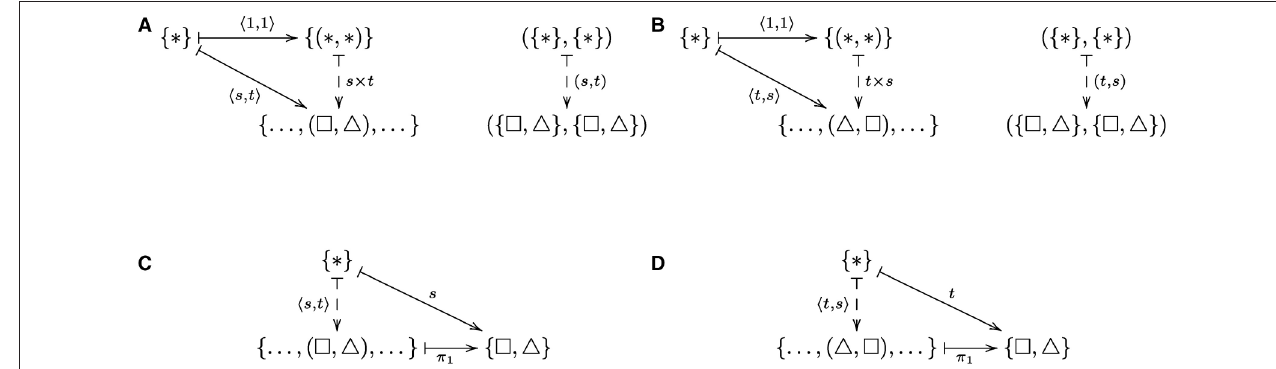
FIGURE 1 | Systematicity with regard to (A) the pair (square, triangle) and (B) the pair (triangle, square). The arrow h s , t i corresponds to the capacity to generate the representation for (square, triangle), indicated as the symbol pair ( (cid:3) , △ ). This arrow is composed of the arrow h 1 , 1 i , which is common to all shape pairs, and the arrow s × t . Arrow s × t is constructed by applying a functor (not shown) to the pair of arrows ( s , t ), which correspond to the basic capacity to generate a representation for square and triangle, respectively. The objects in these categories are sets and the arrows are functions, where 7→ indicates the action of the function on set elements, and dashed arrows indicate uniqueness, i.e., the only arrow that satisfies the equation h s , t i = s × t ◦ h 1 , 1 i . The symbol ∗ indicates an element whose name is unimportant. Note that { ( ∗ , ∗ ) } is a one-element set containing the (ordered) pair with the (unnamed) element ∗ at both positions, and ( {∗} , {∗} ) is a pair with the one-element set {∗} at both positions. Systematicity with regard to (C) the capacity to infer that the first shape of the pair (square, triangle) is square and (D) the capacity to infer that the first shape of the pair (triangle, square) is triangle, where the common arrow π 1 is the projection that returns the first component of each pair. The arrows that are the sources of h s , t i and h t , s i in (C,D) are not